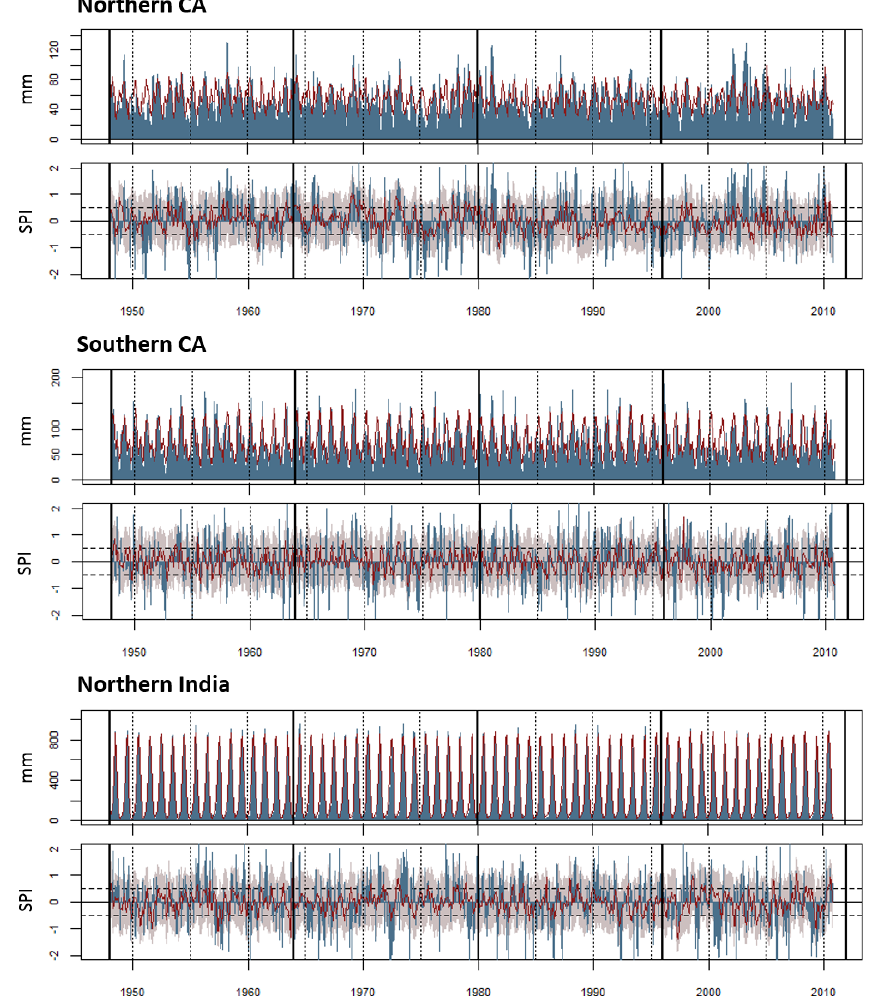
Figure 6. Observed running 3-month precipitation totals (blue bars) and modeling results (red line) of the F [1:3] model for selected target regions. The upper panels show absolute precipitation totals for running 3-month periods, the lower panels show the corresponding SPI index for each 3-month period, respectively. Shaded areas indicate the 90% interval of the residual-based probabilistic forecast. Black verticals indicate the division of the time series into four independent evaluation